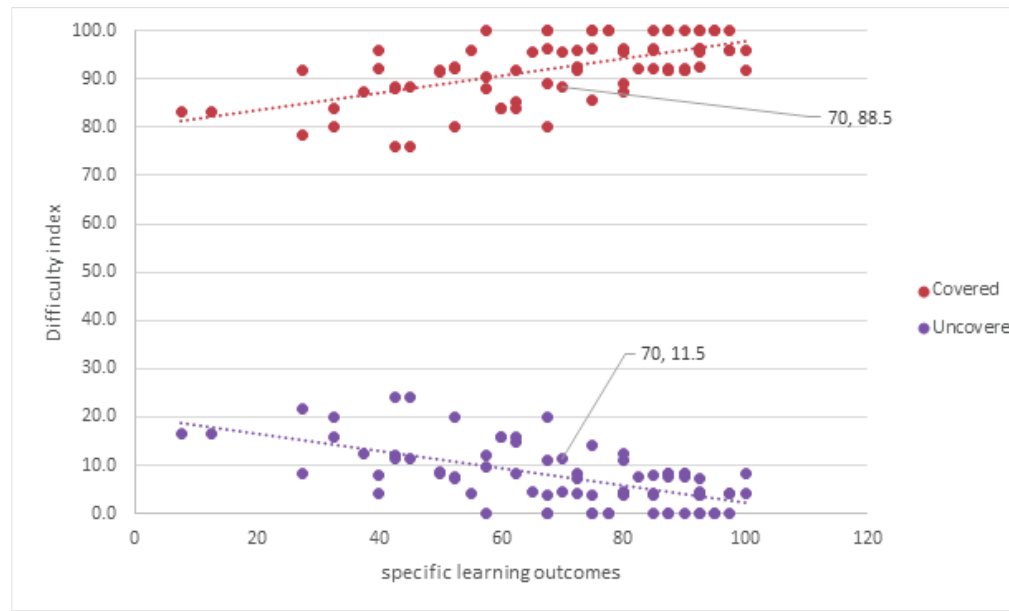
Figure 2: Correlation between the difficulty index of items and the specific learning